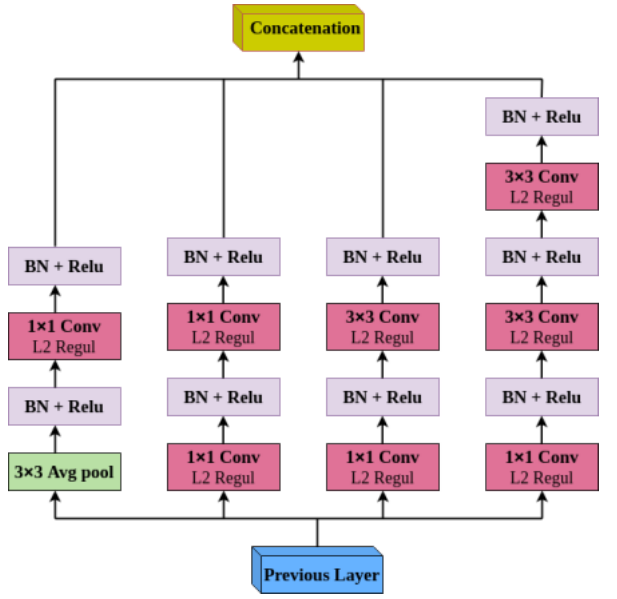
Figure 3. Modified inception